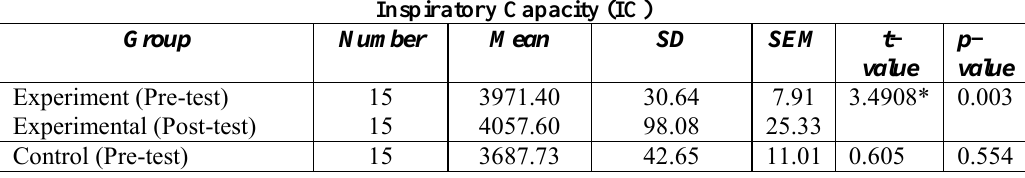
Fig. 11. Descriptive Statistics of Vital Capacity (VC) of (a) Experimental (Pre & Post) and (b) Control (Pre & Post) group of University Level Girls Descriptive Statistics of Inspiratory Capacity (IC) of University Level